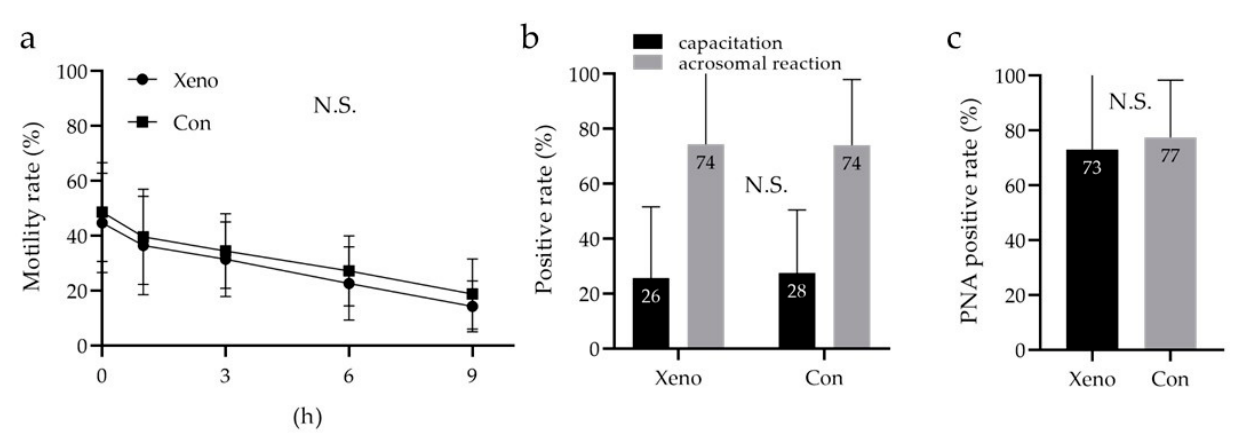
Figure 6. Quantitative analysis of sperm motility with a longevity curve, capacitation status, and acrosome reaction. ( a ) Quanti- tative motility of sperm with longevity was assessed using Makler counting chamber measurements every 0, 1, 3, 6, and 9 h. ( b ) Capacitation status and acrosome reaction assessed by chlortetracycline (CTC)/Hoechst 33258 (H258) imaging under a fluorescence microscope. ( c ) Assessment of the acrosome reaction with lectin from Arachis hypogaea (peanut) conjugated FITC and Ethidium Homodimer-1 using flow cytometry. Two-way repeated measures ANOVA was performed in ( a ), Mann–Whitney U test—in ( b , c ). The data are expressed as the means ± standard deviations ( n = 9). Xeno: the developed xeno-free cryopreservation reagent consisting of a low-Mw CPA (7% v / v Glyc), a macro-Mw CPA (0.3% w / v CPLL), and a saccharide (0.3 M Raf); low-Mw CPA, low-molecular-weight cryoprotective agent; macro-Mw CPA, macromolecular-weight cryoprotective agent; Con, commercial cryopreservation reagent (Fujifilm Irvine); N.S, no signif- icant.